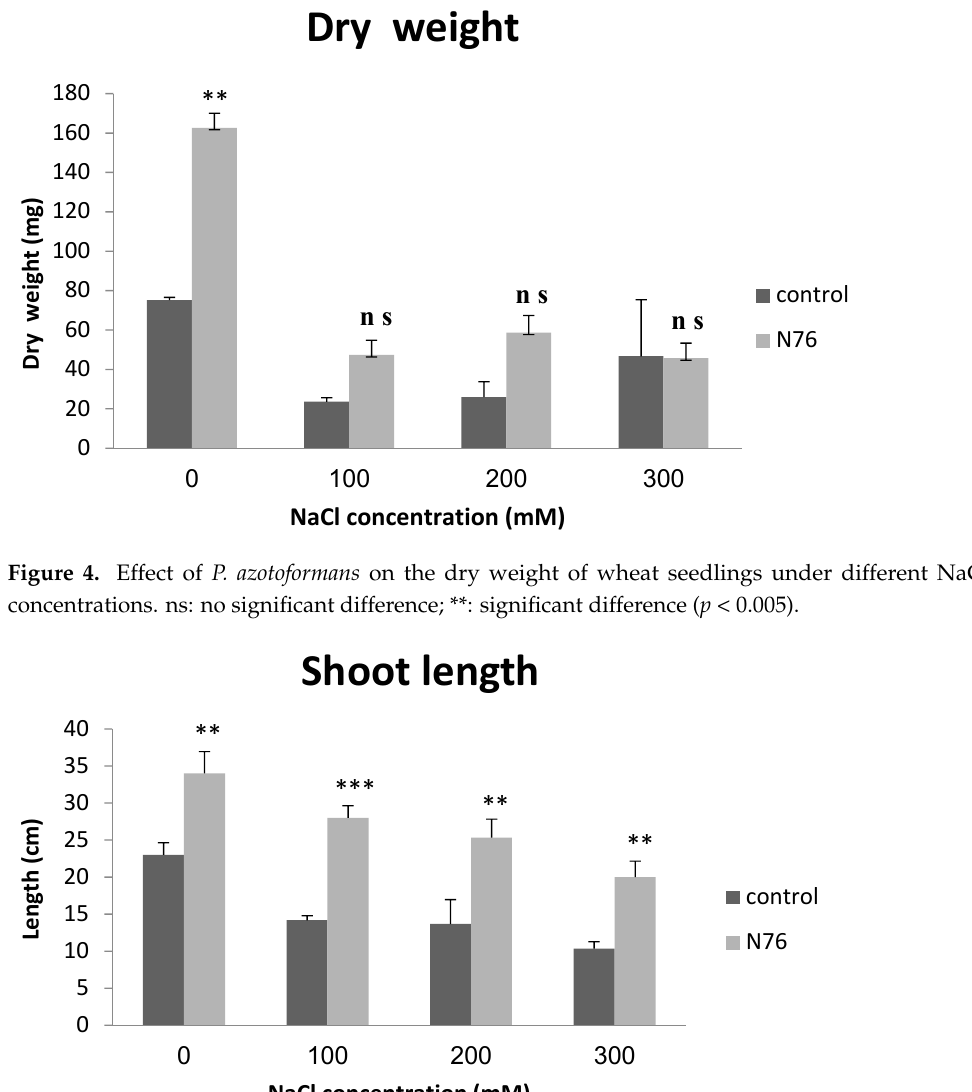
Figure 4. Effect of P. azotoformans on the dry weight of wheat seedlings under different NaCl con- centrations. ns: no significant difference; **: significant difference ( p < 0.005).